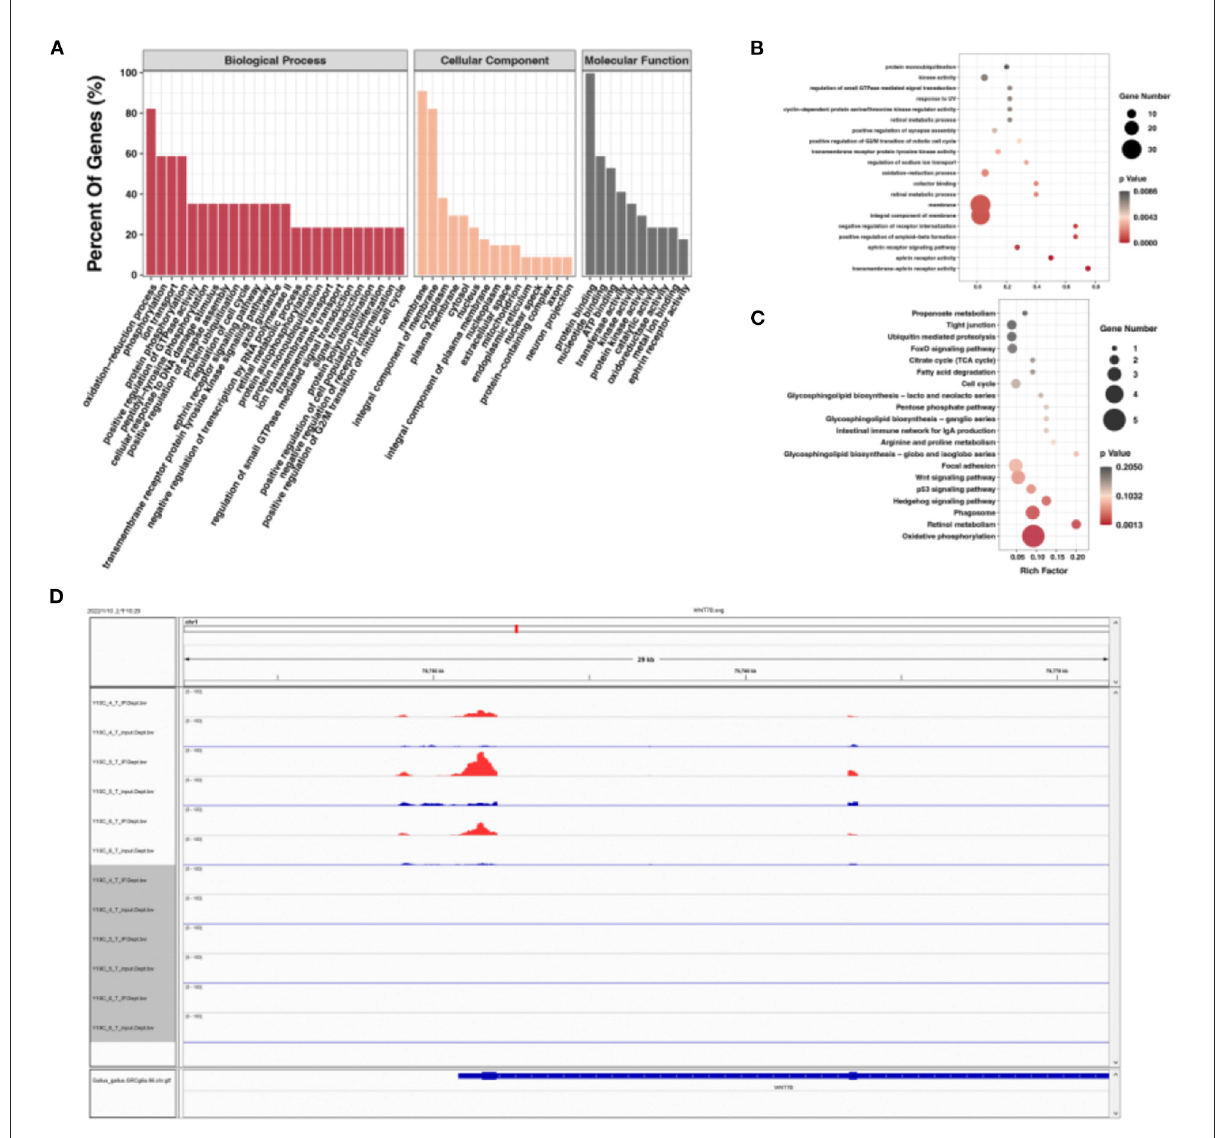
FIGURE5 Integrated analysis of m6A-seq, mRNA-seq, and miRNA-seq data. (A) GO enrichment barplot of miRNA-m6A-genes. (B) GO enrichment scatterplot of miRNA-m6A-genes. (C) KEGG enrichment scatterplot of miRNA-m6A-genes. (D) The visualization of m6A abundances in WNT7B mRNA transcripts in E10 and